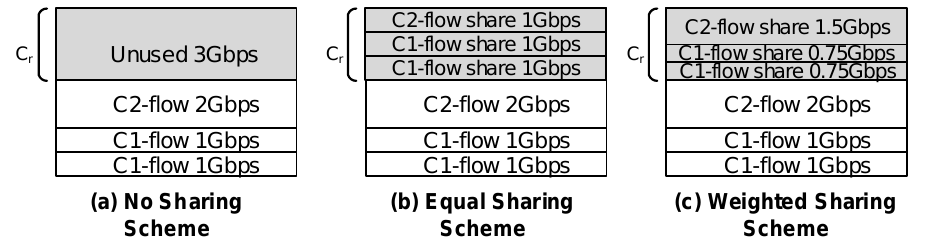
Figure 1. Various schemes for sharing residual capacity C r